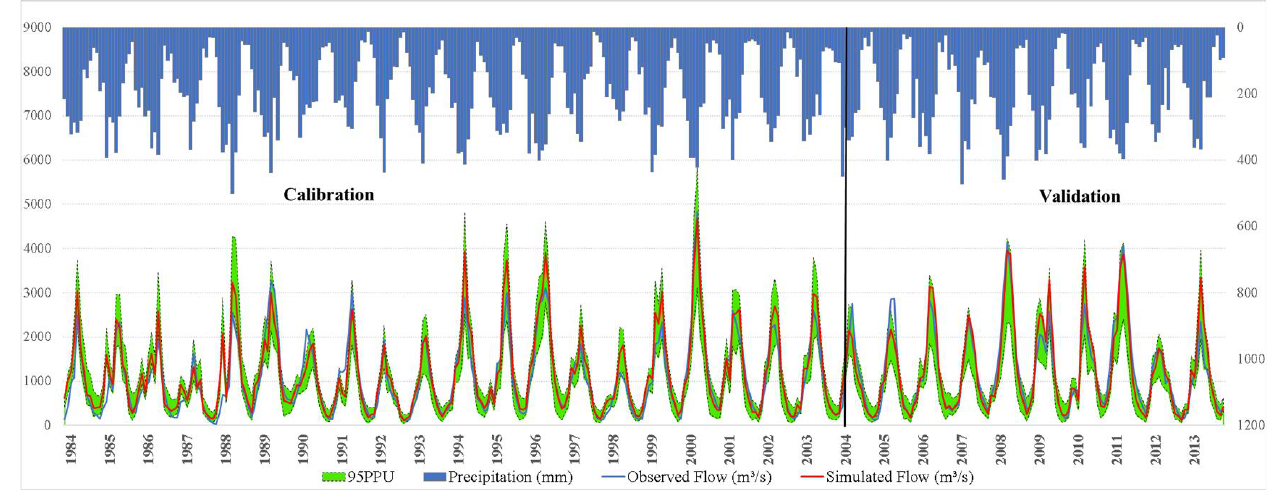
Figure 4. Observed and simulated flow rate and 95PPU.